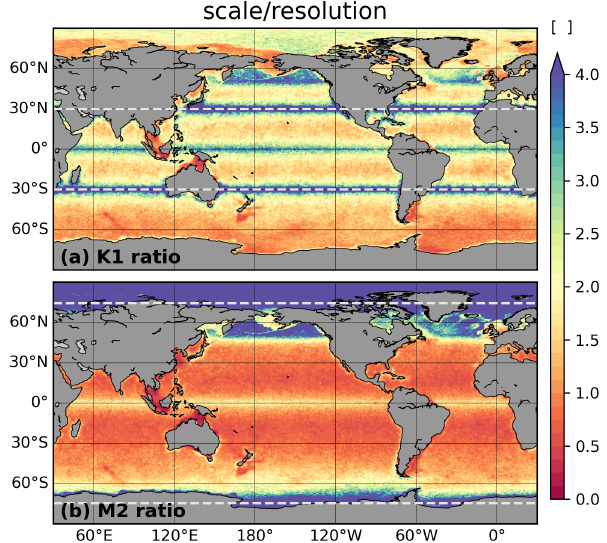
Figure 11. The ratio of mode-1 K1/M2 internal tide scale and mesh resolution. The dashed thick grey line indicates the critical latitudes of internal tides. The calculation of internal tide scale is introduced in Appendix